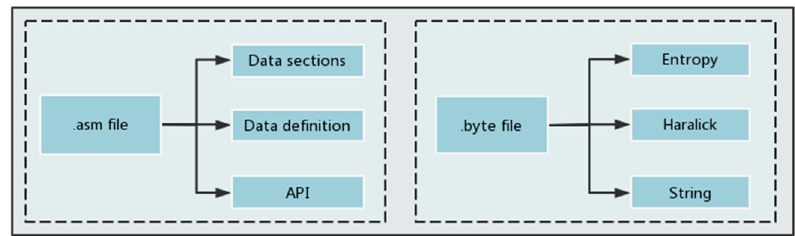
Figure 6. Feature description.